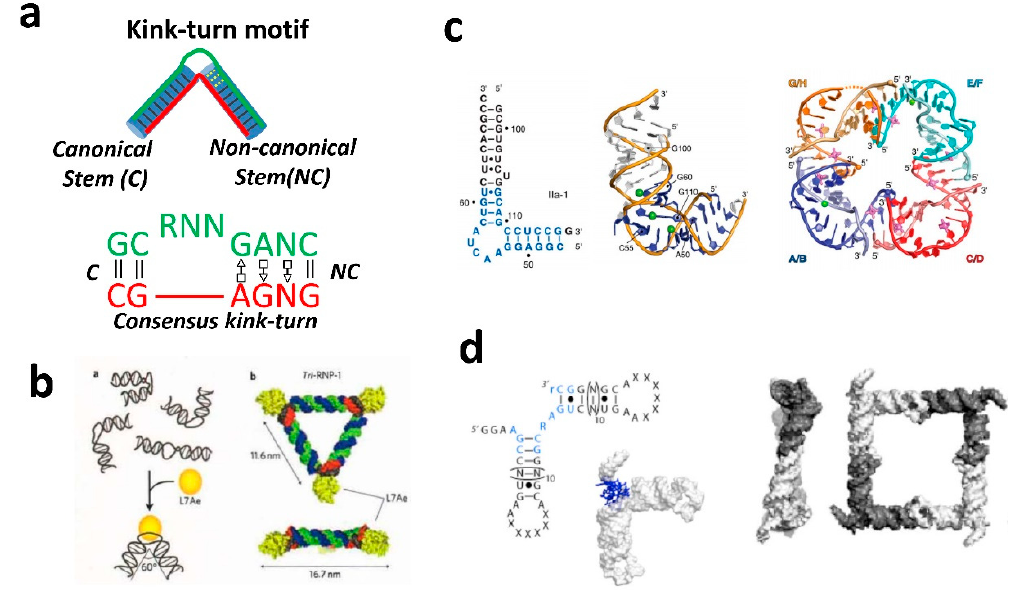
Figure 2. Nano-constructs assembled using motifs that create bends and an RNA helix. ( a ) The kink-turn motif is a well-studied RNA motif that forms flexible and rigid angular conformations in large RNA molecules. ( b ) RNA equilateral triangle assembled using the protein-binding properties of the kink-turn motif. Figure 2b was adapted with permission from [36], Copyright 2011 Springer Nature. Examples of RNA motifs forming 90 ◦ angles that were utilized to assemble tetragonal nanoparticles from the RNA motif of ( c ) subdomain IIa of IRES and ( d) right-angle motif from ribosomal RNA. Figure 2c,d were adapted with permission from ref# [53] (Copyright 2011 PNAS) and ref# [43] (Copyright 2009 American Chemical Society) respectively.